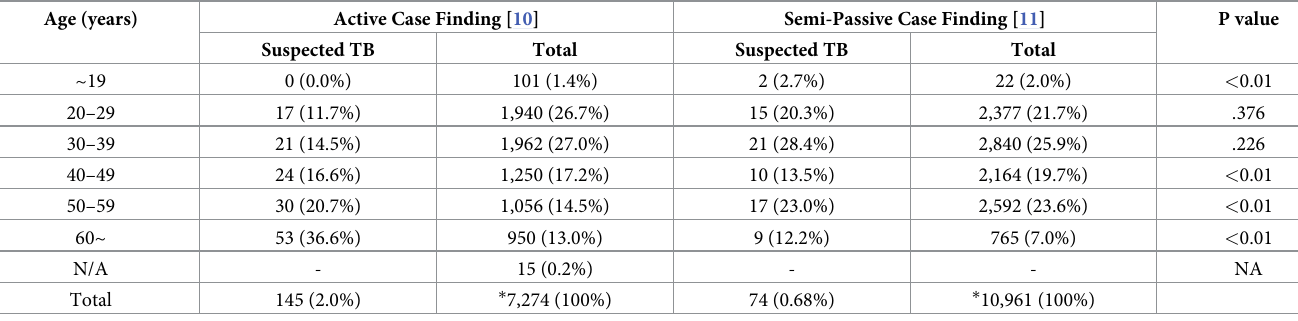
Probability Probability data for the analysis were collected from the above-mentioned TB screening proj- ects, and the other basal values were collected from literature reviews (Table 3). Among the 7,274 cases for ACF and 10,961 cases for semi-PCF, 97.8% and 94.2% were nor- mal on CXR. Among the ‘suggested TB’ group after excluding other abnormalities, 88.3% were inactive TB, and 11.7% were suspected TB. The false normal rate of CXR was 30.8%, and 0.4% of the inactive TB was positive on SC. Table 2. Proportion of suspected TB by age group in ACF with CXR and semi-PCF with CXR. Age